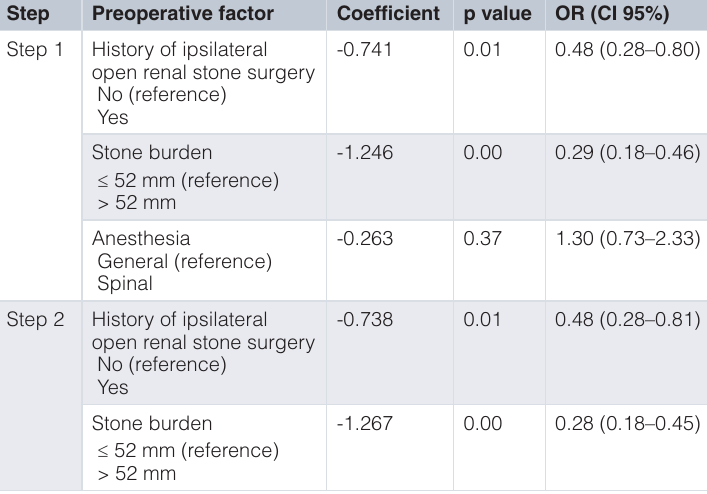
Dataset 1. Raw data for Table 1, Table 2, and Table 3 of ‘Factors affecting stone free rate of primary percutaneous nephrolithotomy on staghorn calculi: a single center experience of 15 years’ http://dx.doi.org/10.5256/f1000research.9509.d134117